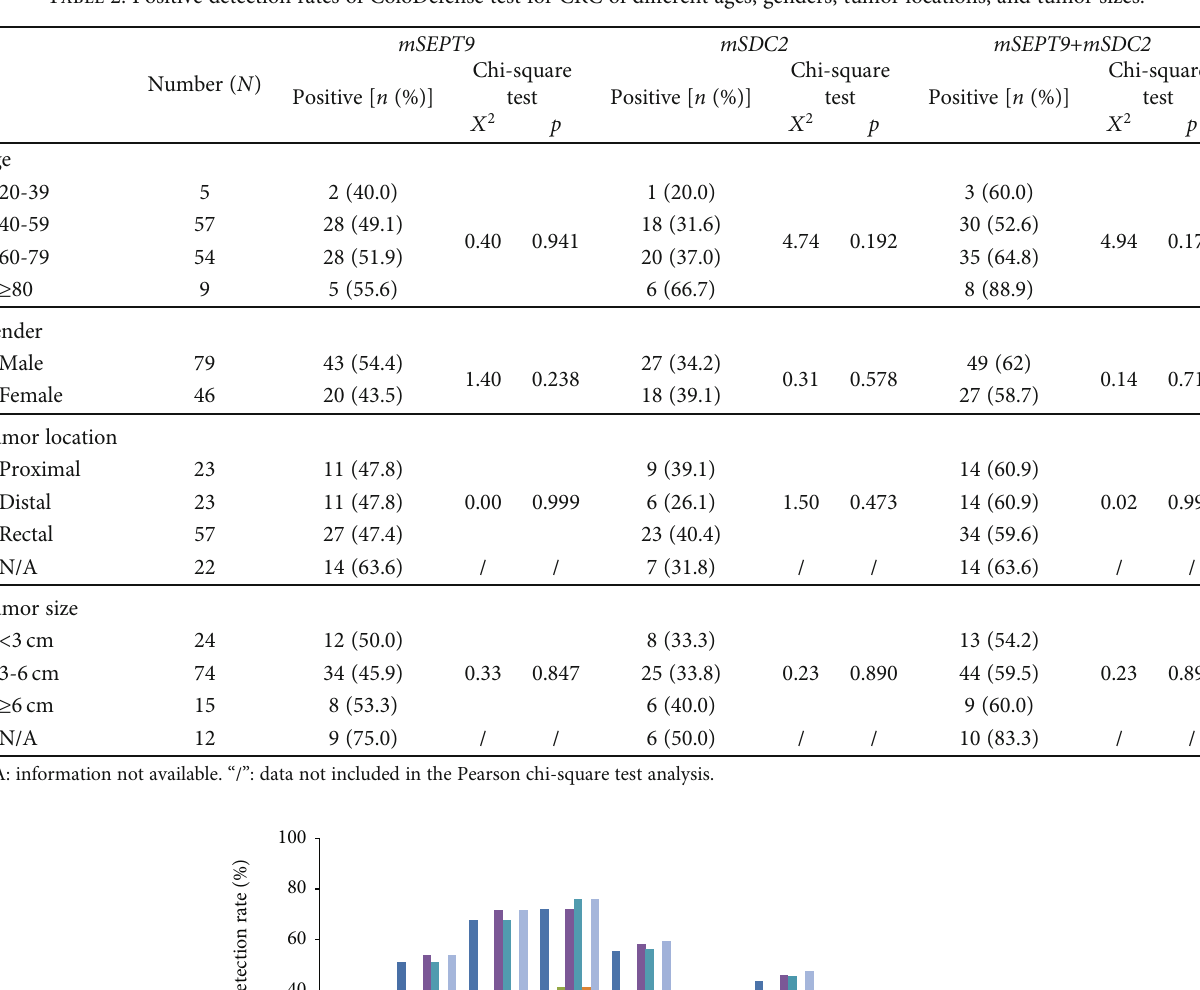
Table 2: Positive detection rates of ColoDefense test for CRC of di ff erent ages, genders, tumor locations, and tumor sizes.